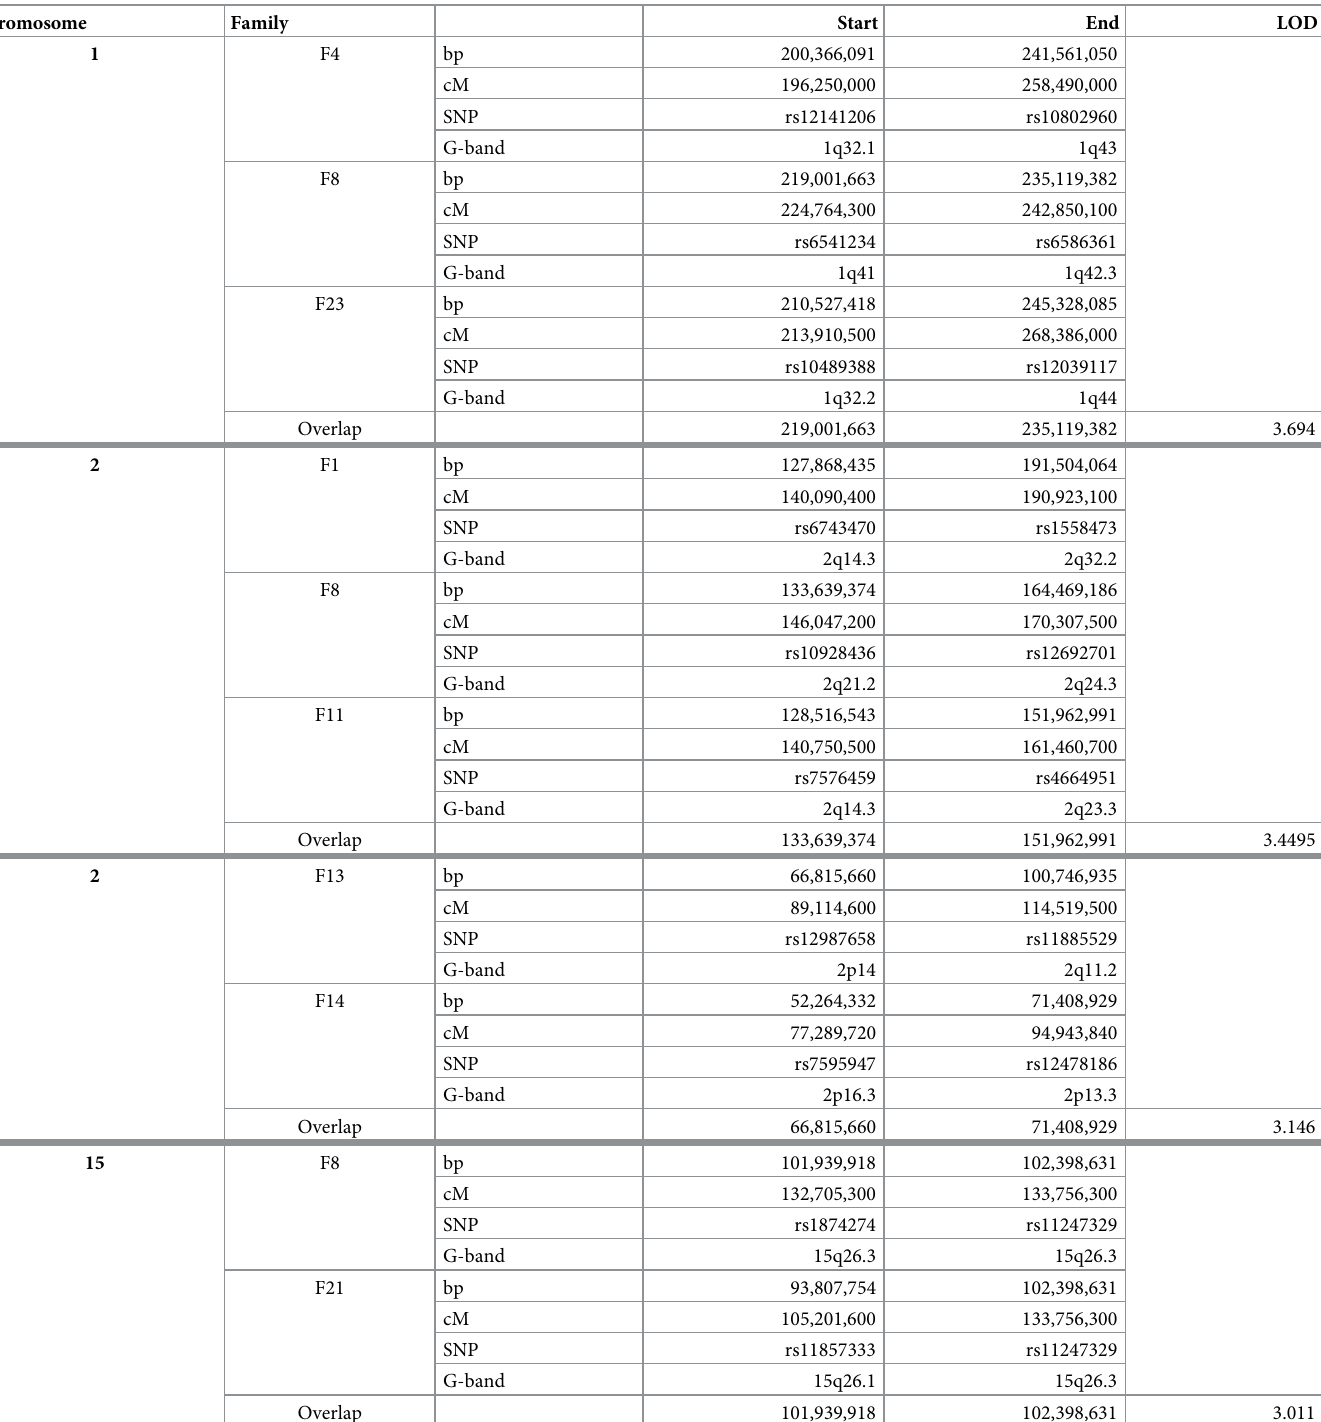
Table 1. Loci with genome-wide significant LOD score � 3 on chromosomes 1, 2, and 15.